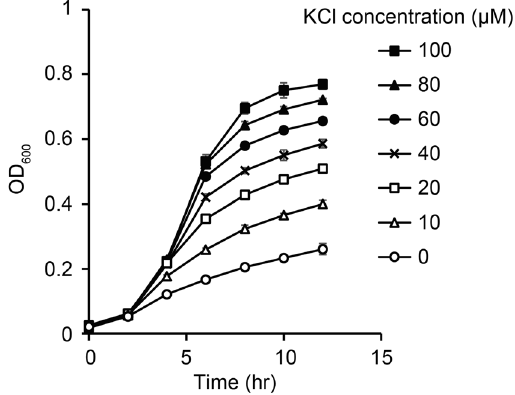
Figure 1. Growth of E. coli in the K + -limited conditions. E. coli WT was cultivated in the K + -free minimal medium supplemented with different concentrations of KCl and the OD 600 values were monitored. Data are presented as means of three independent cultures, and error bars represent standard